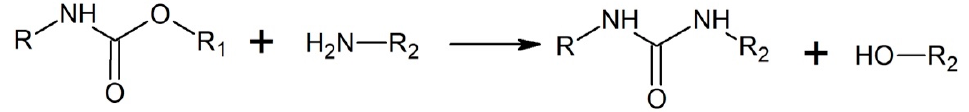
Figure 5. Polyurethane aminolysis.